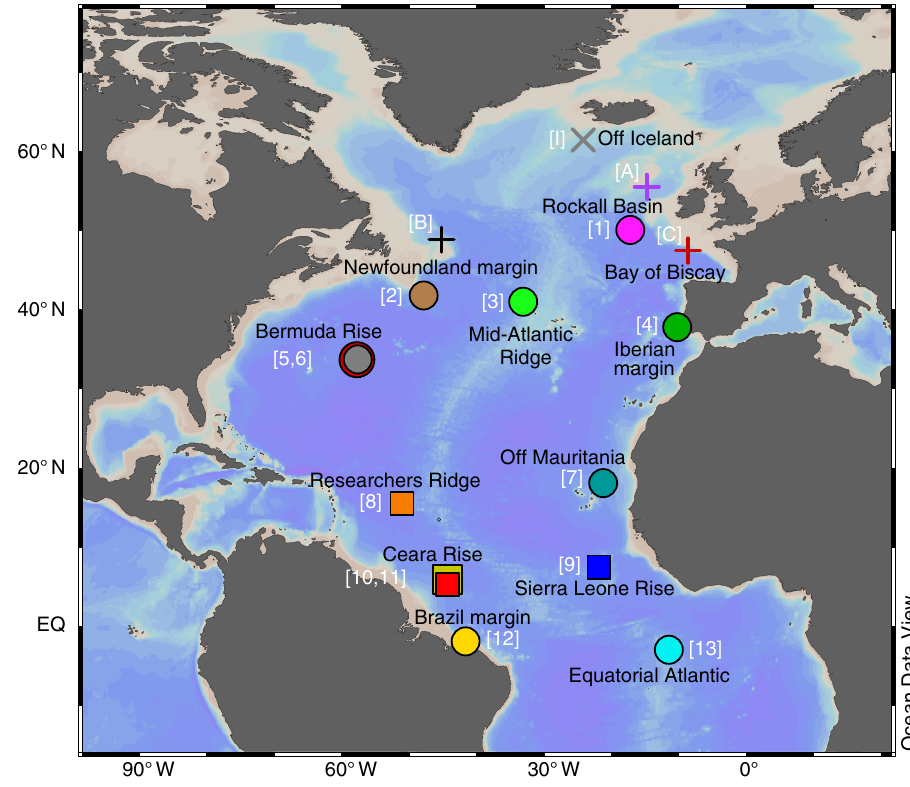
Fig. 1 Location map of paleo-proxy records presented in the main discussion. These include sedimentary 231 Pa/ 230 Th records (square and circle symbols indicate new and previously published records respectively), sortable silt fraction (10 – 63 μ m) grain size record (cross symbol), ice-rafted debris and meltwater discharge records ( ‘ plus ’ symbols). Numbers and letters in brackets denote the identity of the sediment records plotted in Figs. 2 – 4, with references listed in Table 1. The map was generated using the Ocean Data View programme